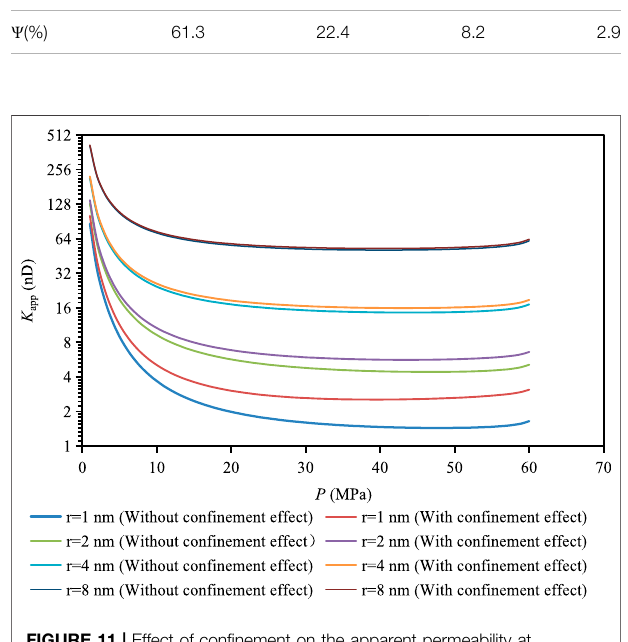
FIGURE 11 | Effect of con fi nement on the apparent permeability at different pore radii.